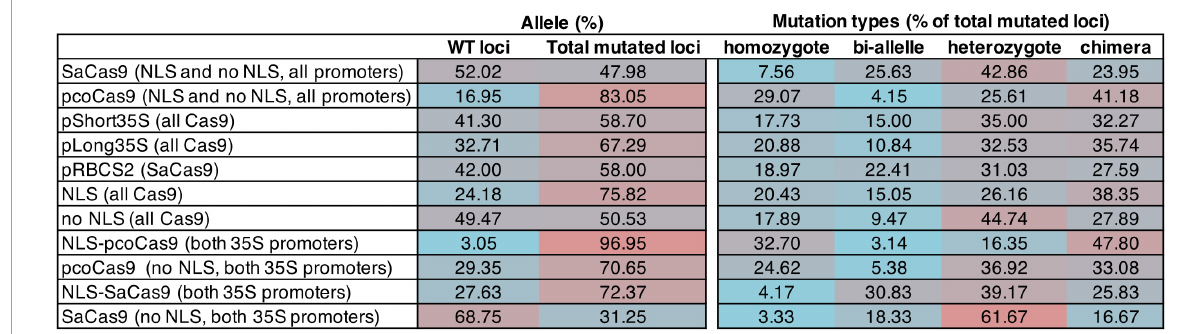
FIGURE2 Table summarizing the mutagenesis efficiency of the CRISPR/Cas9 constructs for gRNA loci in BnaA02.TAA1 (guide1 and guide2) and BnaC02.TAA1 (guide1 and guide2). The mutagenesis efficiency is calculated as the percentage of the type of mutation on the total loci per construct (16–30 independent hairy root lines per construct). Data are pulled for a comparison of efficiency. The percentages of the type of alleles per loci (WT, mutated loci) and types of mutations (homozygote, bi-allele, heterozygote, chimera) over the total number of (mutated) loci are counted. Homozygote: the two alleles of a locus have an identical mutation. Bi-allele: the two alleles of a locus have different mutations. Heterozygote: only one allele is mutated. Chimera: more than two mutations per locus. Supporting data are shown in Supplementary Table 4